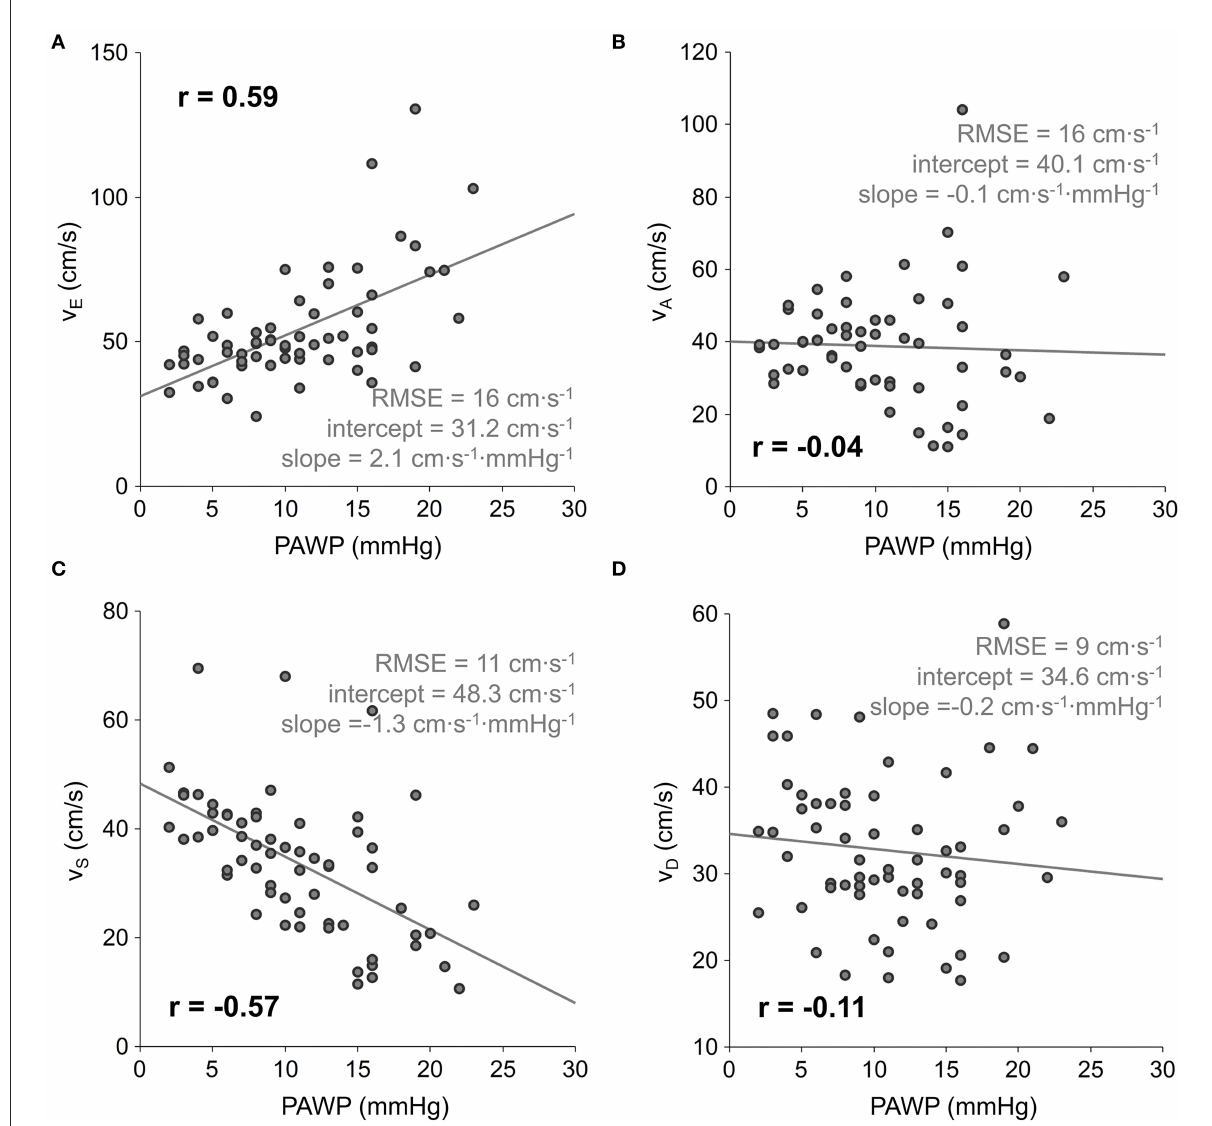
FIGURE2 Scatter plots and linear regressions of early diastolic LA peak outflow v E (A) , late diastolic LA peak outflow v D (B) , systolic LA peak inflow v S (C) , and early diastolic LA peak inflow v D (D) velocity on PAWP. PAWP, mean pulmonary artery wedge pressure; r, correlation coefficient; RMSE, root-mean-square